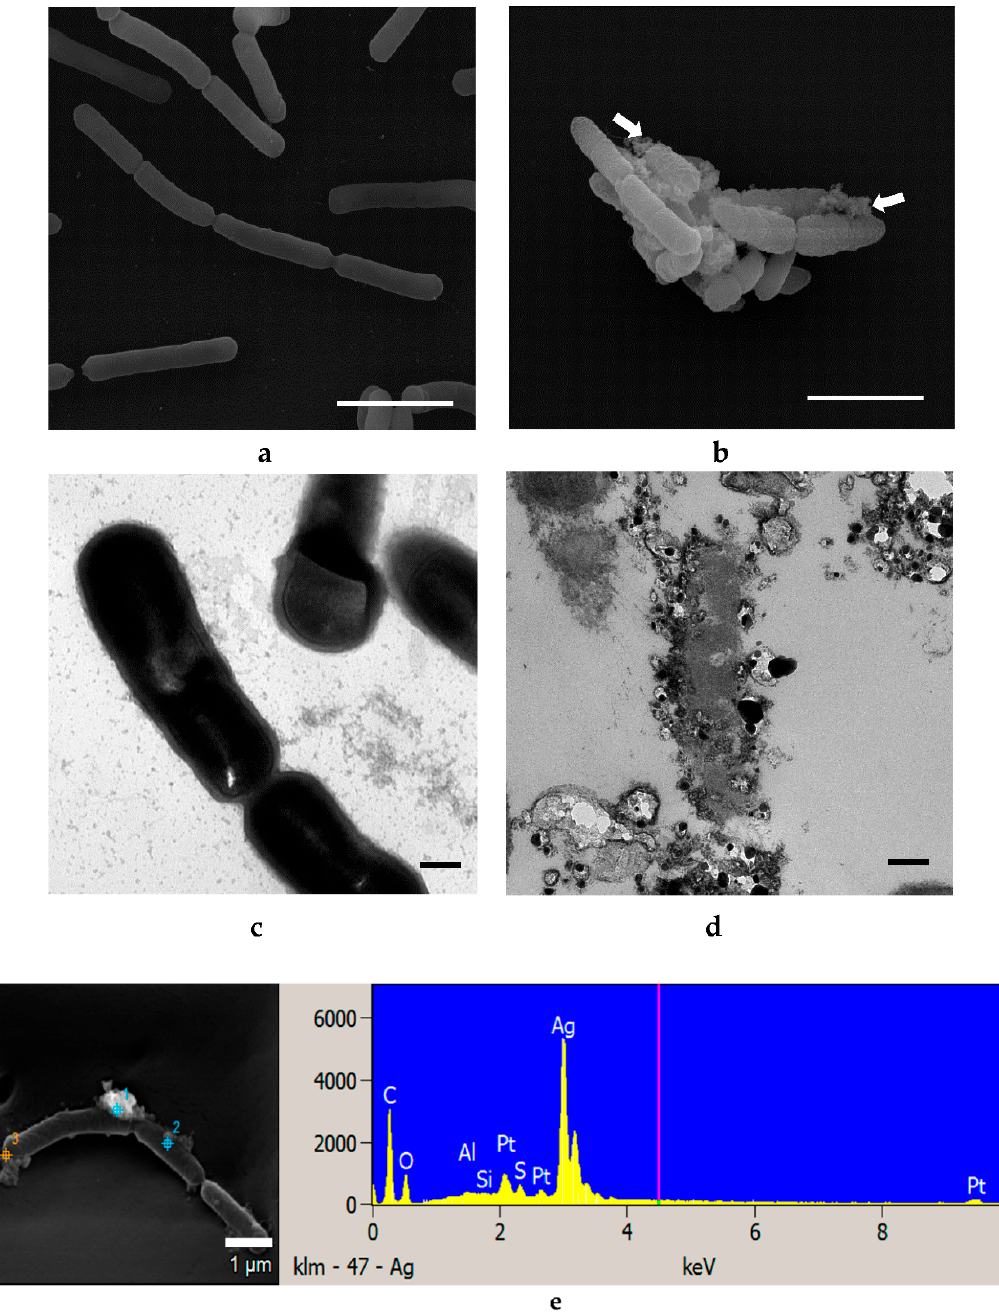
Figure 8. SEM ( a , b ) and TEM ( c , d ) images of L. acidophilus untreated with Ag NPs ( a , c ) and treated with 4.6 mM Ag NPs ( b , d ). SEM-EDS analysis shows Ag NP presence on cell surfaces ( e ). White arrows indicated clusters of Ag NPs. SEM scale bar ( a , b ) = 3 µ m, TEM scale bar ( c , d ) = 0.2 µ